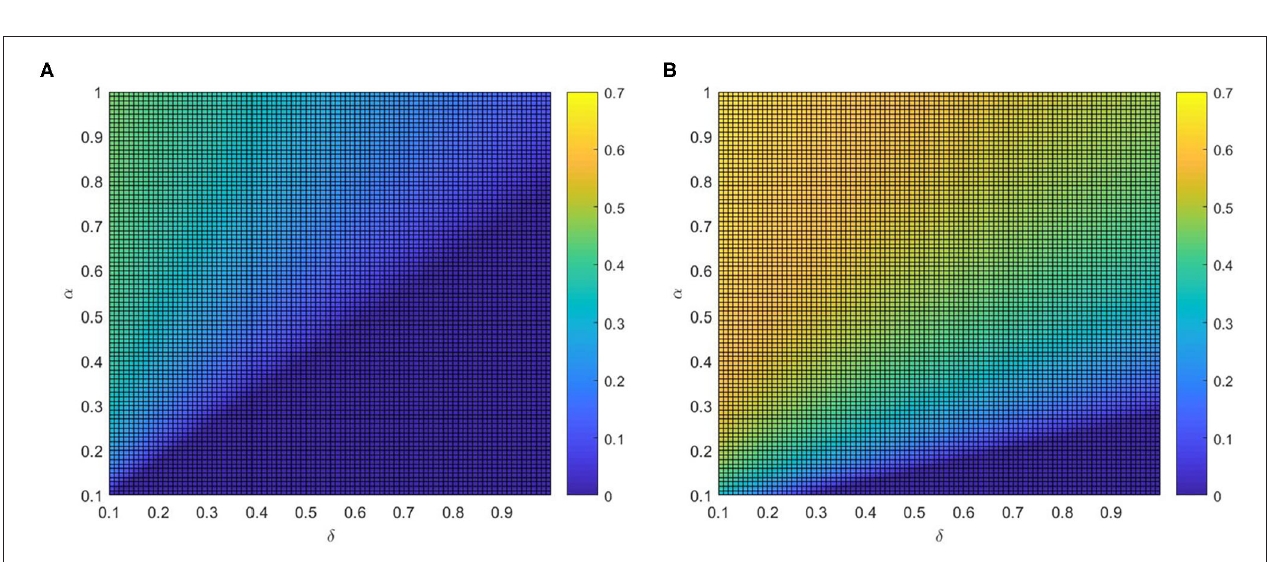
FIGURE 8 | The fraction ρ V of vaccinated individuals in the stationary state, where ε = 0.05, λ = 0.2 and ρ = 0.05. (A) η = 0.2 and (B) η =